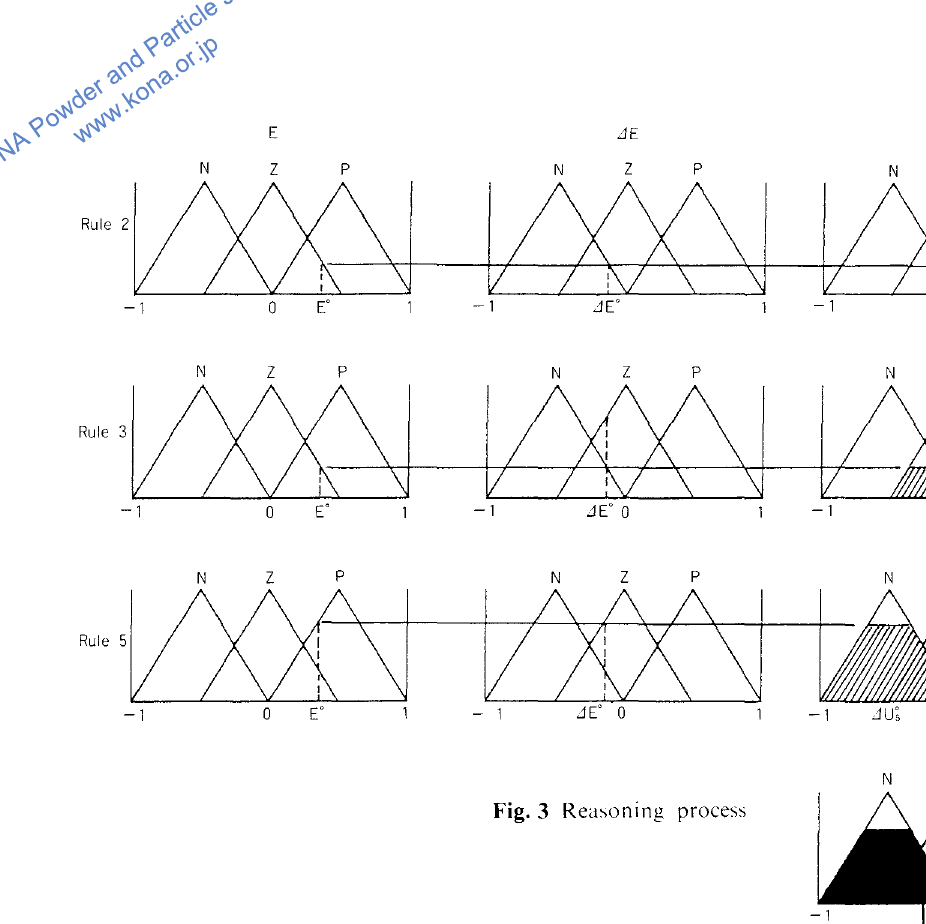
Fig. 3 Rea-,oning